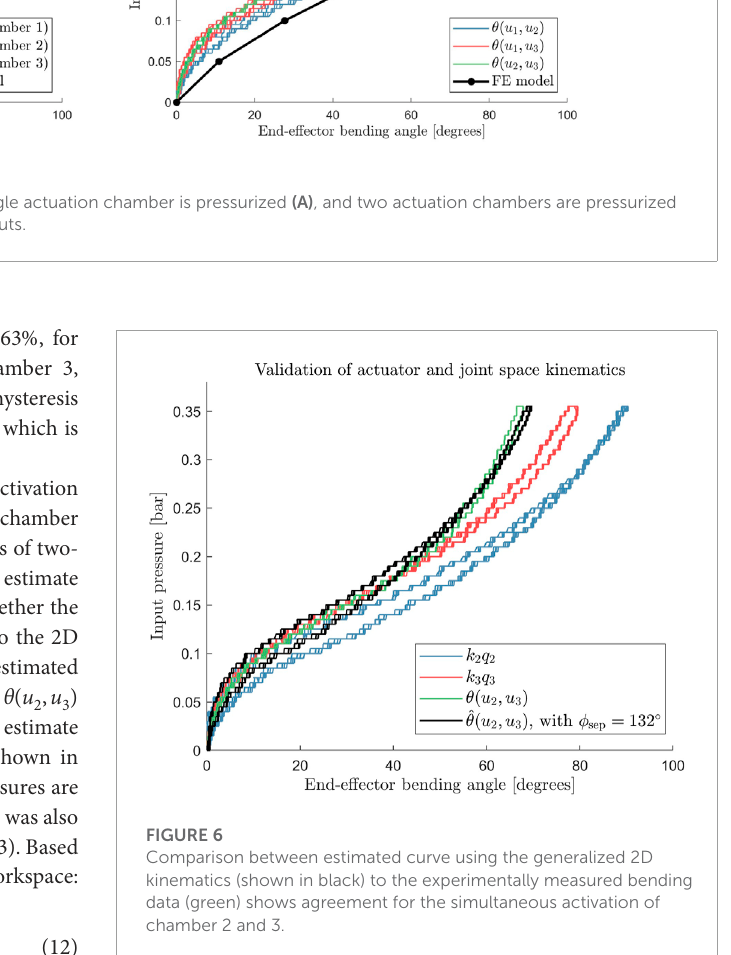
FIGURE 6 Comparison between estimated curve using the generalized 2D kinematics (shown in black) to the experimentally measured bending data (green) shows agreement for the simultaneous activation of chamber 2 and